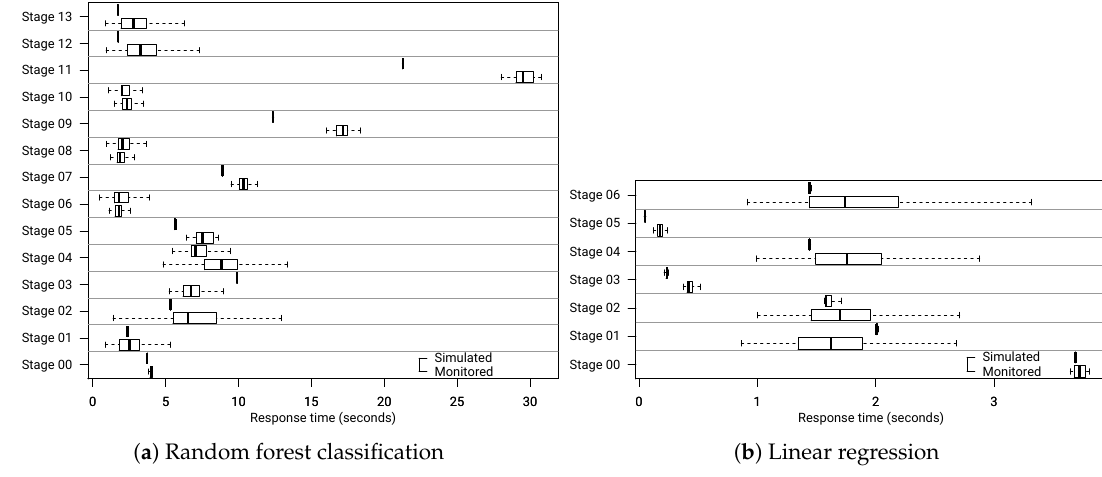
Figure 5. Response time statistics of Spark tasks for each stage (four worker nodes, huge data workload).